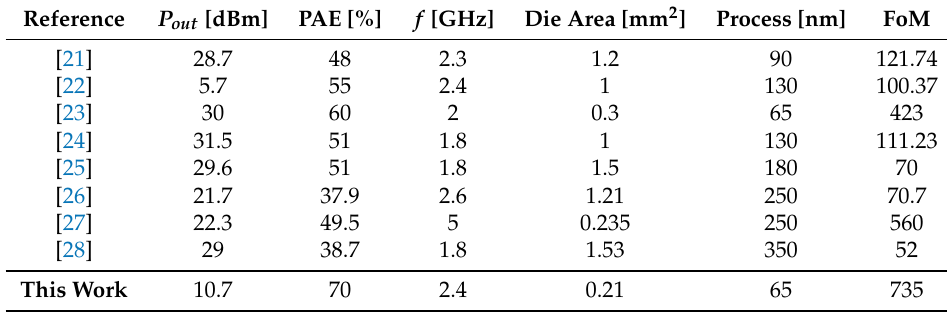
Table 2. Comparison of state-of-the-art class-E PA designs. Figure-of-Merit